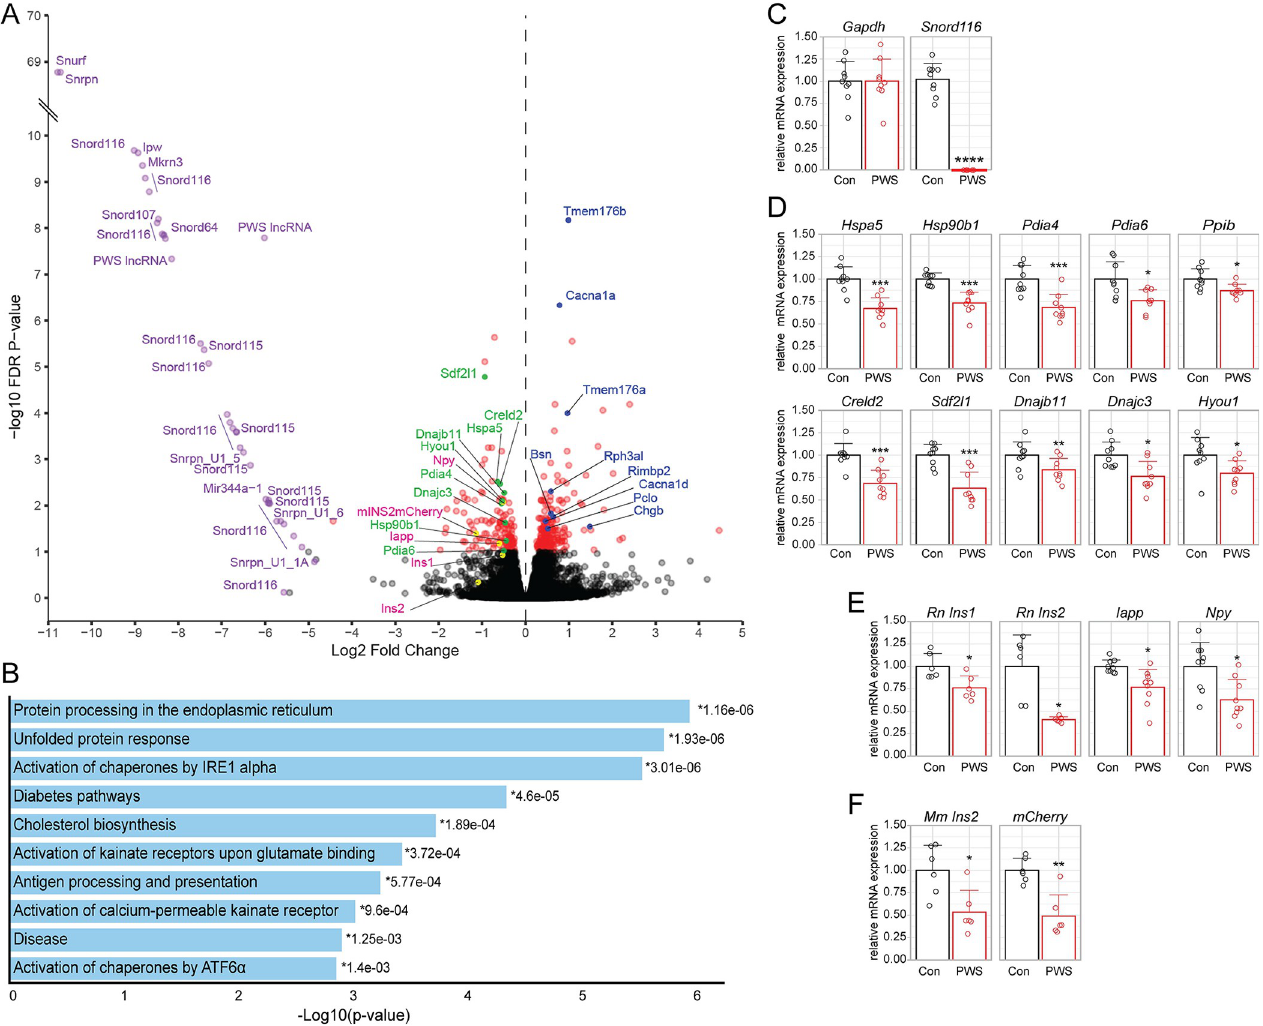
Fig 4. Genome-wide transcriptome alterations in PWS-deletion vs . control INS-1 lines identifies significant differentially expressed genes (DEGs) including those encoding ER chaperones and hormones. (A) Volcano plot showing statistical significance (-log10 FDR P -value) vs . magnitude of change (Log2 Fold Change) for all expressed genes. Colored data points indicate PWS-imprinted genes (purple), ER chaperones (green), secreted peptides (pink, with yellow dots), proteins involved in neuronal active zone/exocytosis and vesicle acidification (blue), and all other significant genes (red, without labels). (B) Gene set enrichment analysis identifies key biological pathways including those involved in protein processing and the unfolded stress response in the ER. (C-F) Quantitative gene expression analyses for control (Con, black; 5–9, 2, 16) vs . PWS (red; 3, 19–1, 19–4) determined by RT-ddPCR normalized to Gpi levels and to the average expression in control INS-1 lines, for (C) Gapdh and Snord116 (PWS) control genes, (D) ten downregulated DEGs encoding ER chaperones, (E) endogenous Rattus norvegicus (Rn) genes encoding β -cell hormones, and ( F ) an exogenous transgene in the INS-1 lines encoding Mus musculus ( Mm ) Ins2 with an mCherry biomarker. Statistical comparison by Welch’s t-test: * , P < 0.05; ** , P < 0.005; *** , P < 0.0005; **** , P <